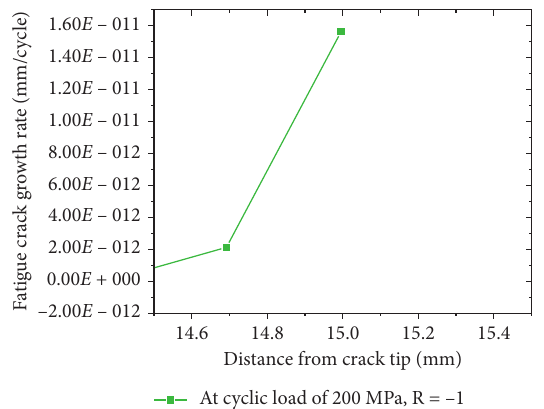
Figure 9: Fatigue crack growth rate vs. distance from crack tip.